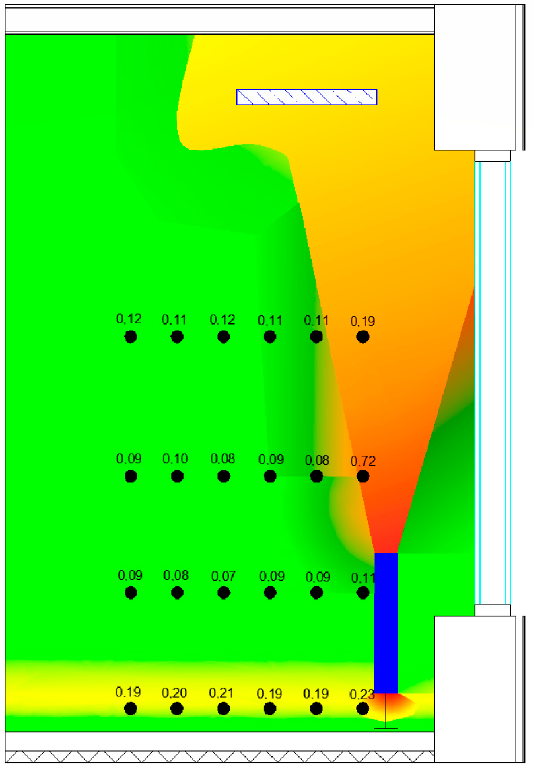
Energies 2022 , 15 , x FOR PEER REVIEW Figure 18. Air jet velocities for cooling radiators, HIGH speed. Figure 18. Air jet velocities for cooling radiators, HIGH speed.